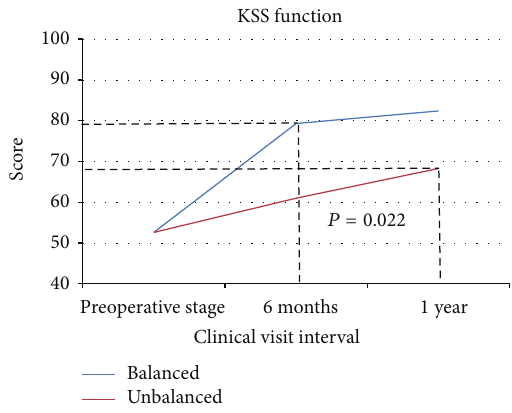
Figure 3: The lines represent the KSS function scores for the balanced and unbalanced patients from preoperative stage to 1 year. The dashed lines indicate the disparity between the balanced and unbalanced patients’ functions